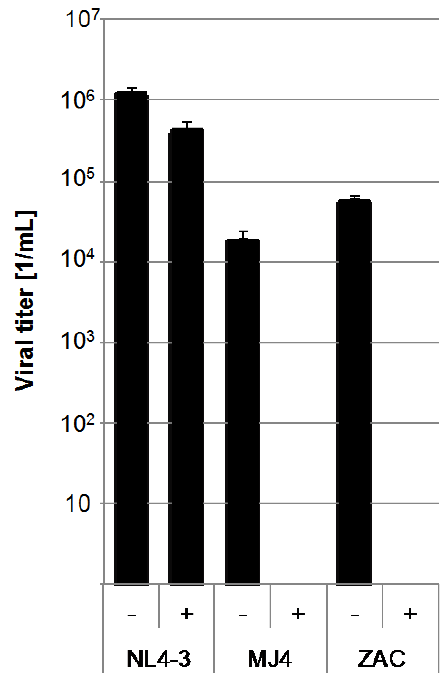
Figure 3. CCR5 is the coreceptor used by both pMJ4 and pZAC. In order to determine the co-receptor usage TZM-bl cells were pre-incubated with 10 ng/mL of the CCR5 inhibitor Maraviroc (indicated by (+)) for 1 h and subsequently infected with NL4-3, pMJ4 and pZAC viruses (NL4-3 MOI: 2; MJ4 and ZAC MOI: 0.2). Untreated control cultures are indicated by ( − ). Infected cells were visualized by X-Gal stain and counted. Both pMJ4 and pZAC use CCR5 as coreceptor. Experiments were performed in independent triplicates and the experiment was repeated twice. Error bars indicate the standard deviation within one